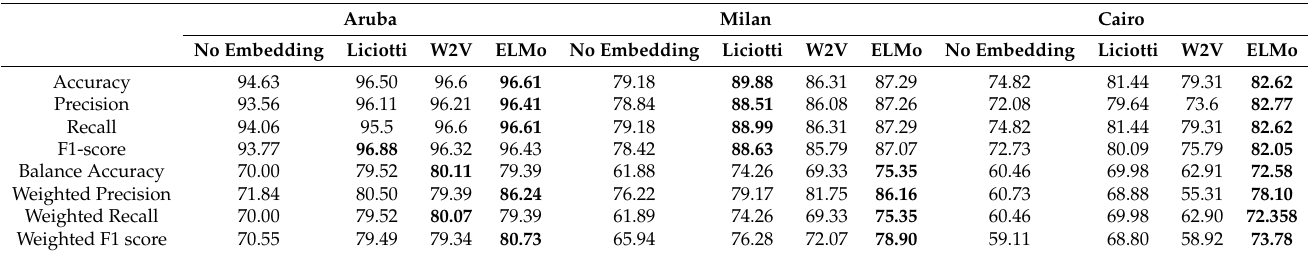
Table 6. Without and with embedding coupled with a LSTM